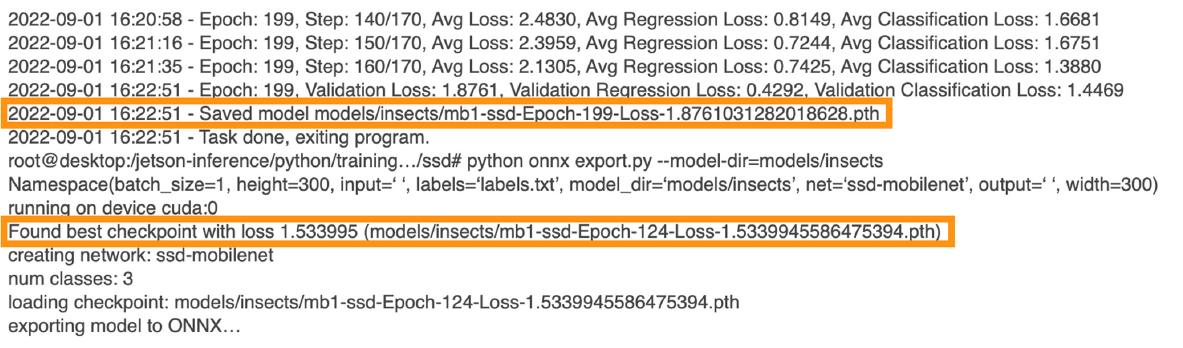
Figure 8. Completed 200 epochs with a validation loss of 1.876103 and still using the 125th epoch with a smaller validation loss.